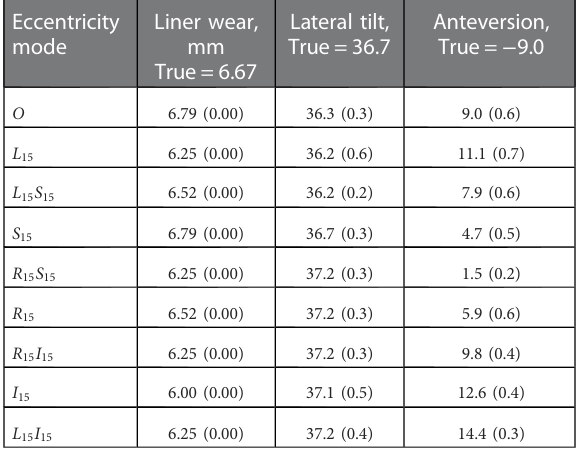
TABLE 4 PolyWare measurement results for nine spatial eccentricity